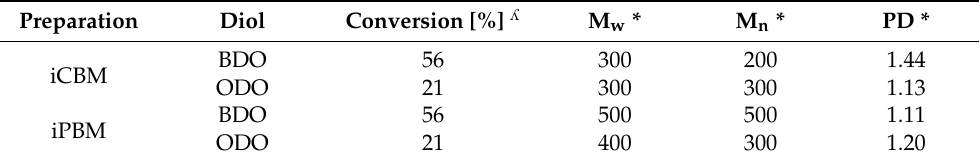
Table 2. Polycondensation of DMA with various diols by different covalently-immobilized